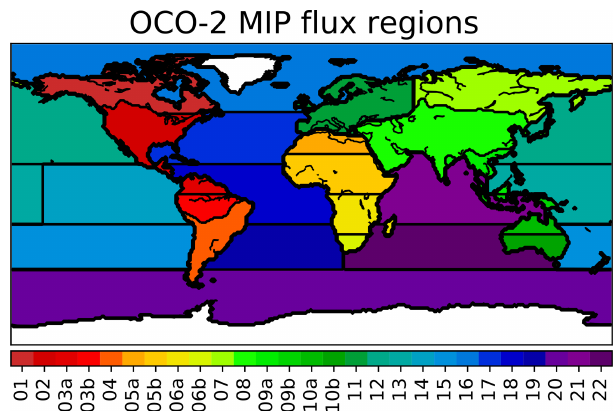
Figure 2. Regions on which prior and posterior gridded fluxes are aggregated for